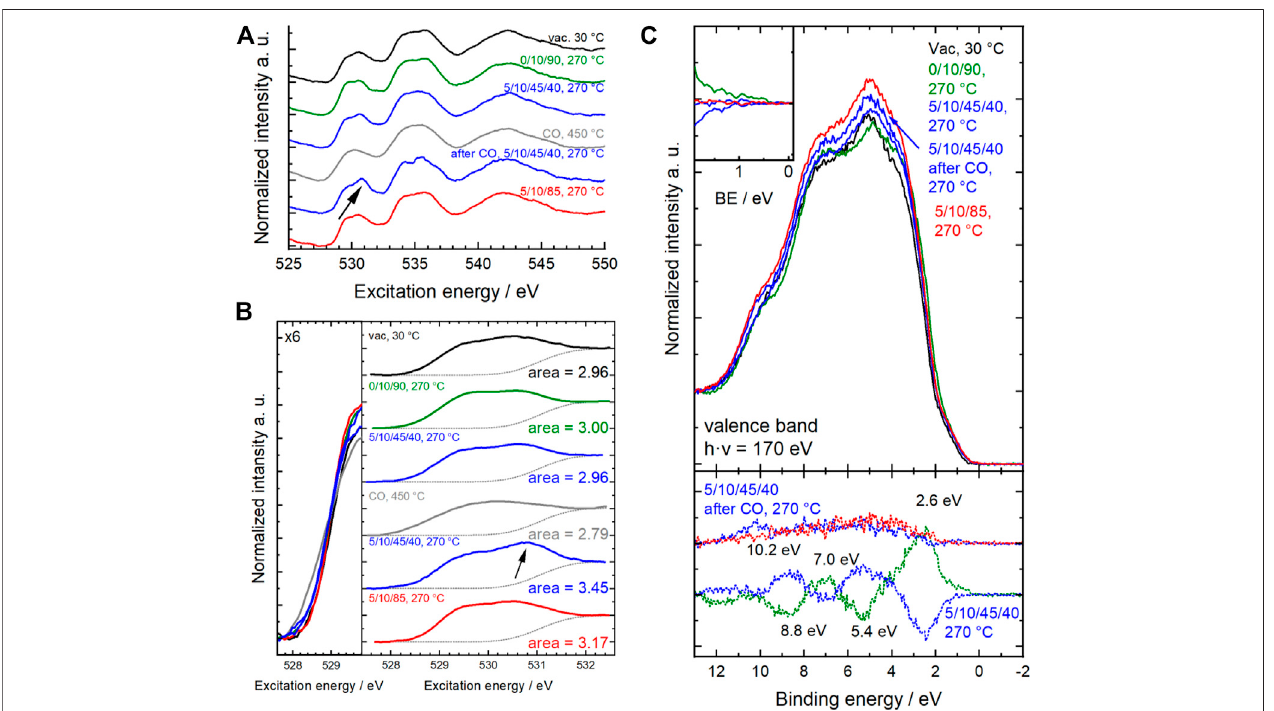
FIGURE 10 | (A) Normalized O K-edge spectra measured in different atmospheres and temperatures. (B) Corresponding pre-edge range of O K-edges. Left: enlargedoverlayatpre-peakonset.Right:Pre-peakincludingthestepfunctioningreydotsrepresentingthebackground.Resultingareasofpre-edgepeakaregivenon the right. Arrows in (A,B) indicate the same position of most changing range in the pre-edge region. (C) Corresponding normalized valence band spectra measured in differentatmospheresandtemperatures.Inaddition,differencespectraareplottedindotsatthebottom.Enlargeddifferencespectraaredepictedintheinsetatthe top left. Difference spectra show the difference to previous conditions. Conditions are given as C 3 H 8 /O 2 /He/H 2 O (initial – black, 10% O 2 /He – green, wet feed – blue, CO/ He – grey, dry feed – red).